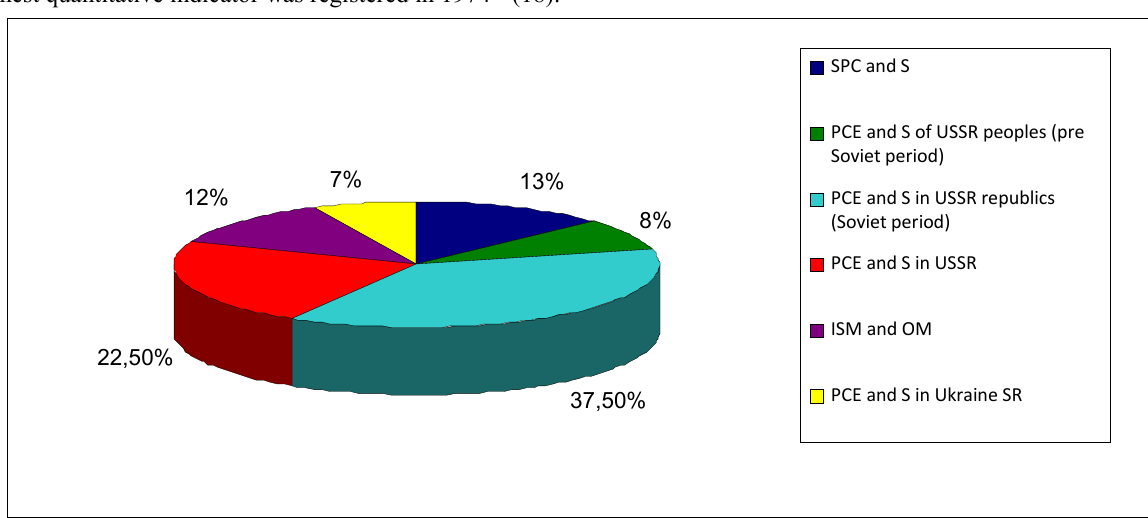
Fig.4. Historic directions of dissertation researches in